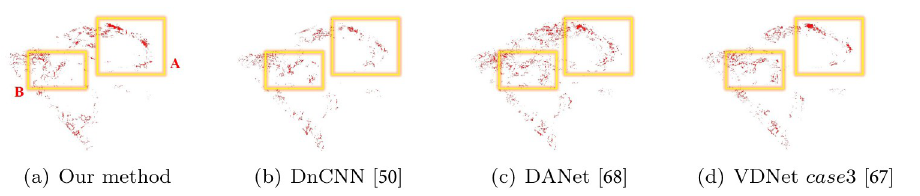
Fig 26. Comparison of foam particles generated in a single frame (at frame 136). (a) Our method, (b) DnCNN [50], (c) DANet [68], (d) VDNet case3 [67].